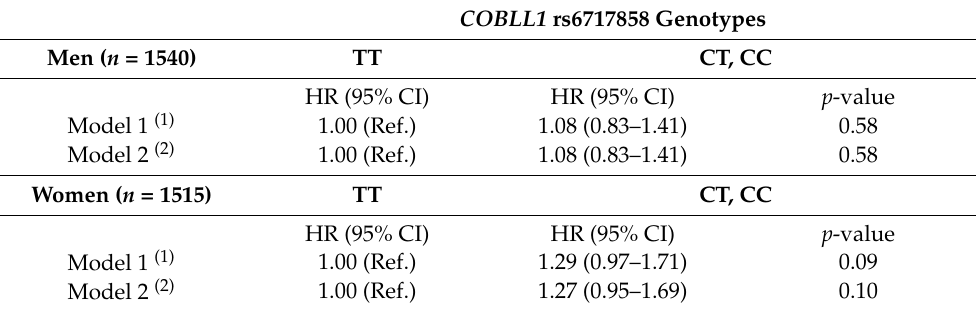
Table 5. Association between COBLL1 rs6717858 genotypes and incidence of